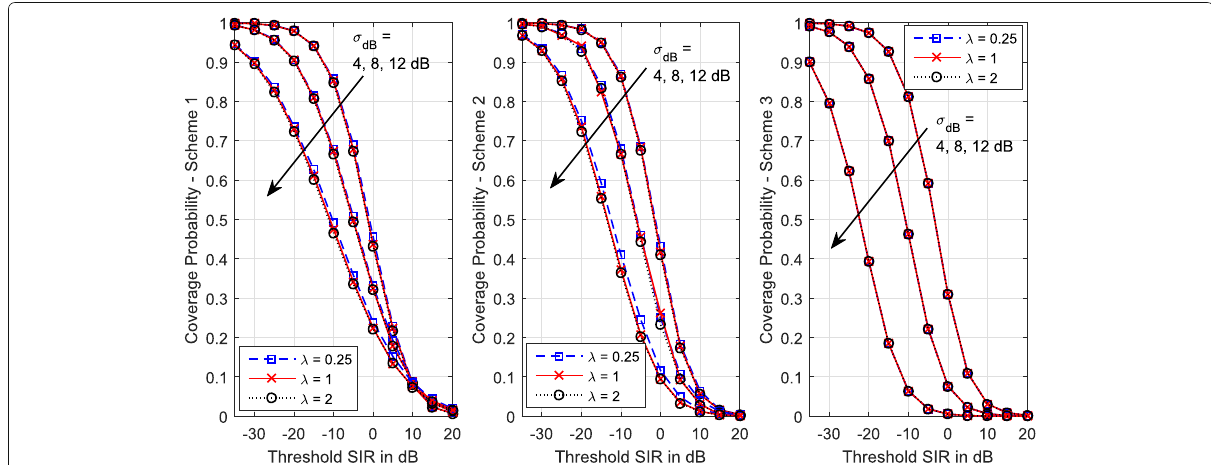
Fig. 3 Coverage probability of the three power control schemes vs SIR threshold for different BS intensities and degrees of shadowing. η = 0.5. λ is in BSs/km 2 , α = 3.5, σ dB = ξ dB